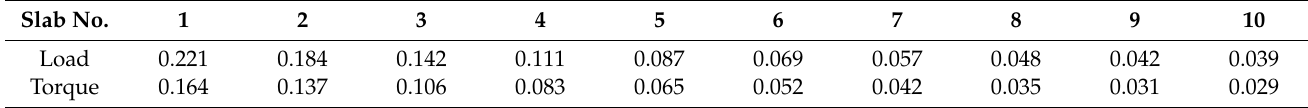
Table 2. The TLD of each slab under the unit force of slab 1.